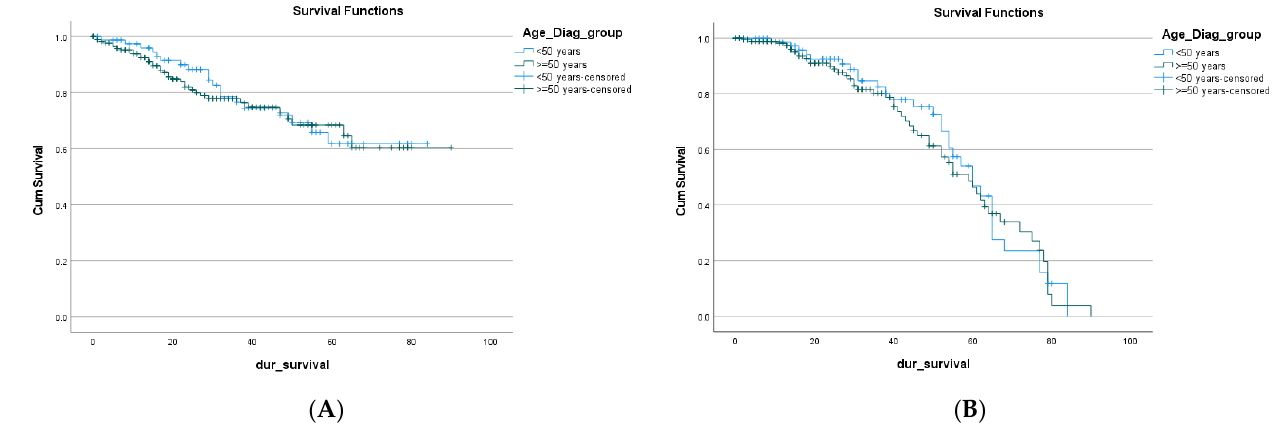
Figure 1. Mortality ( A ) and remission ( B ) of EOCRC and LOCRC.